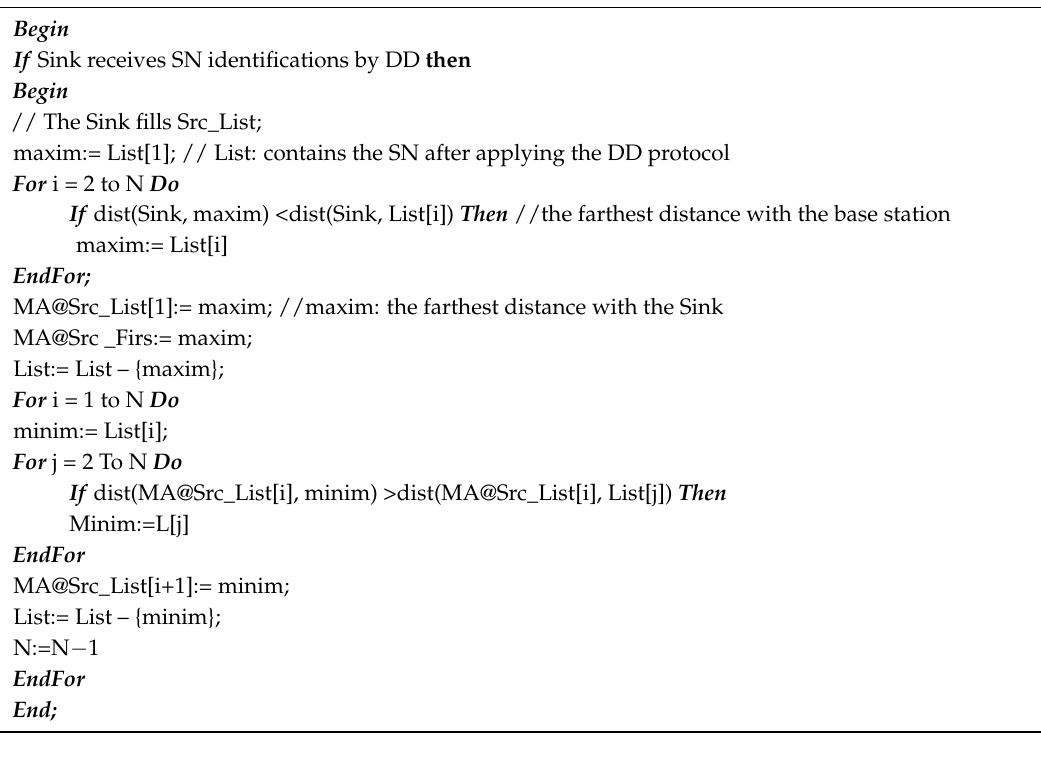
Algorithm 1. Chaining source nodes at the sink